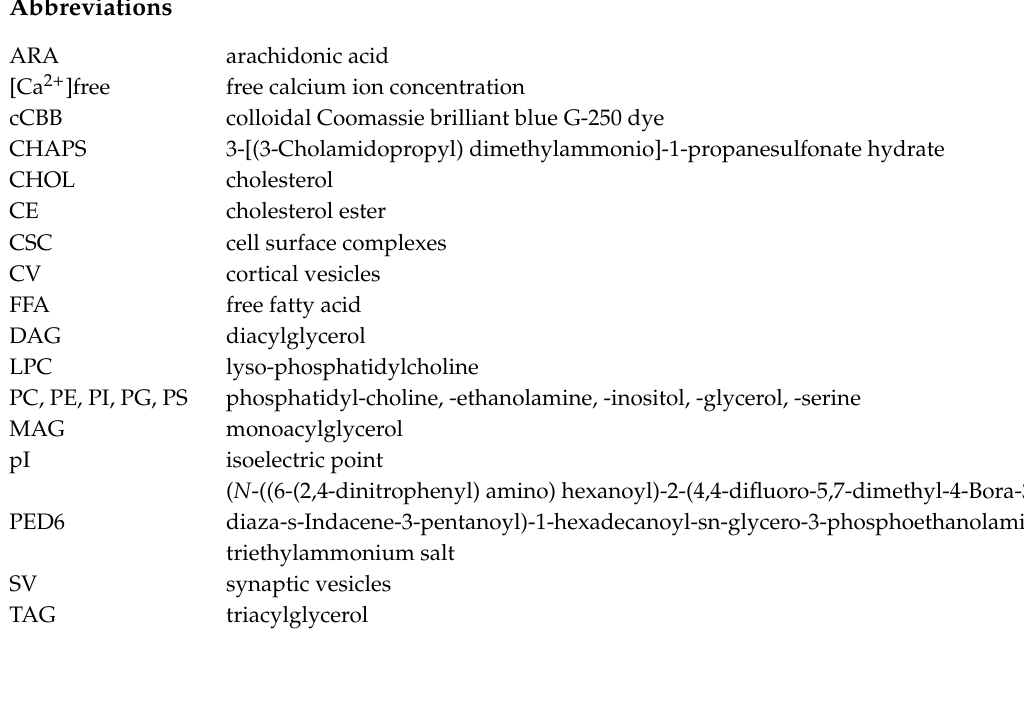
Figure S1: Endogenous TAG levels in ( A ) CSC; n = 3–5 and ( B ) CV; n = 3–8 treated with the indicated doses of LY311727, BEL and FKGK-11, including representative chromatograms showing changes in neutral lipids. Figure S2: ( A ) SDS-PAGE of total CV membrane protein isolated from trypsin treated CV and the parallel untreated control; ( B ) secondary antibody control western blot to identify non-specific protein binding. A total of 5 µ g CV membrane protein per lane was